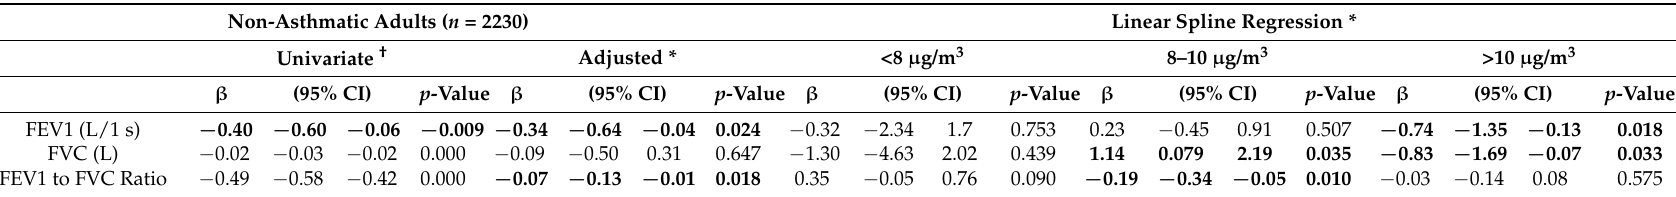
Table 3. Multiple Linear Regression and Linear Spline Regression estimating associations between a ten-unit change in 3-year annual average PM 2.5 ( µ g/m 3 ) * and Pulmonary Health Outcomes.